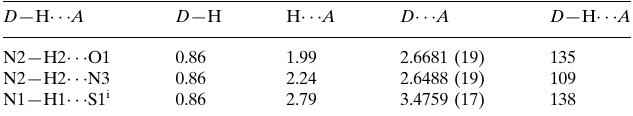
Hydrogen-bond geometry (A˚ , (cid:1)